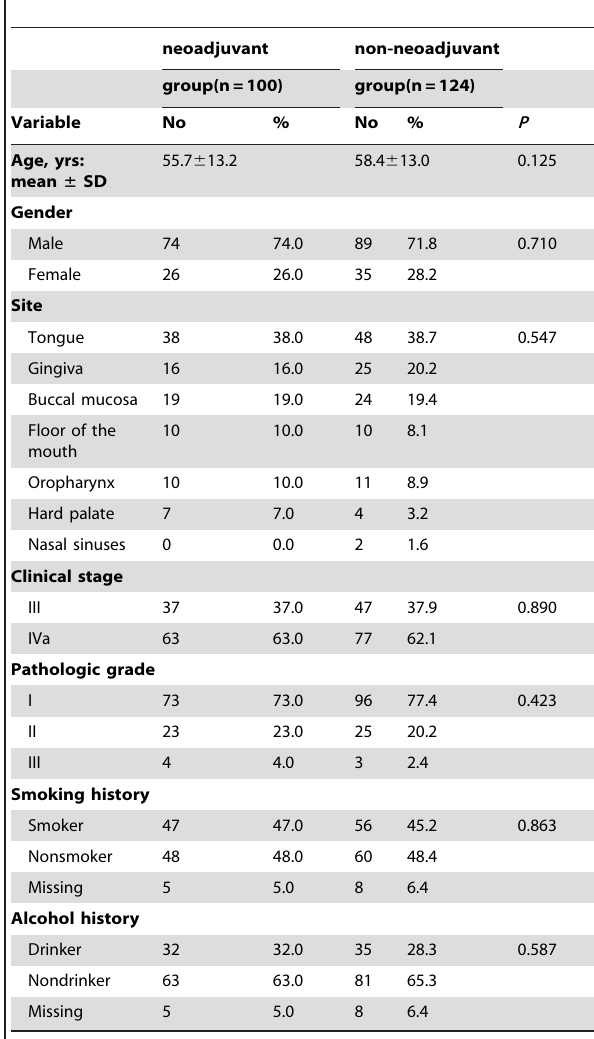
Table 1. Baseline demographics for the 224 patients who participated in the